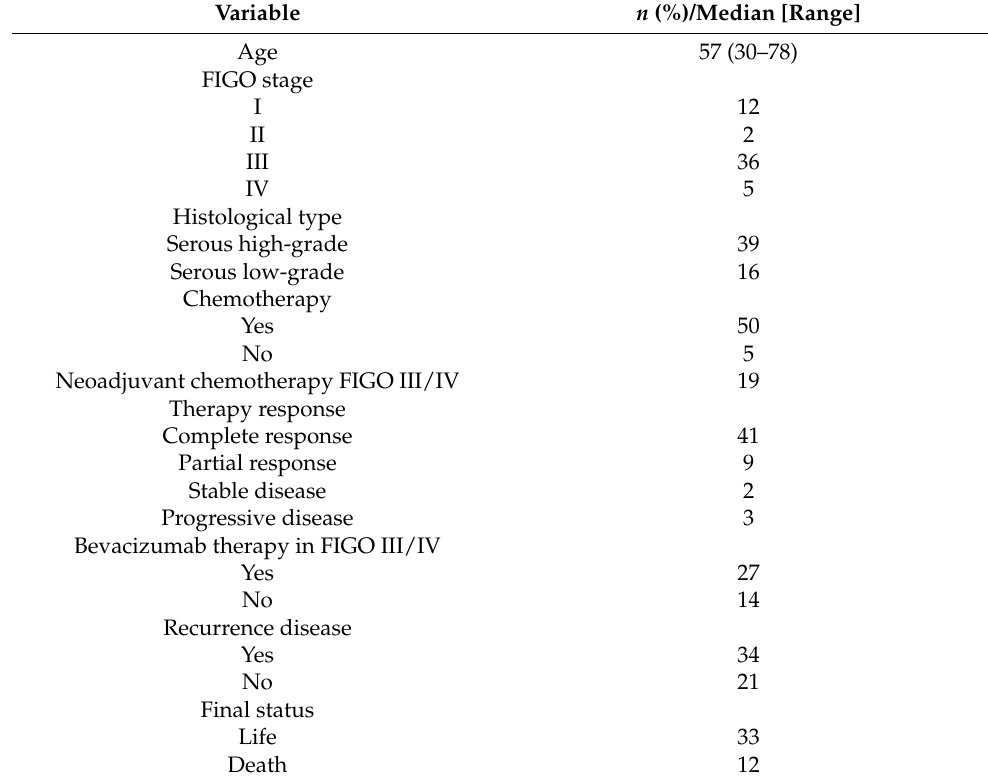
Table 1. Clinicopathological characteristics of 55